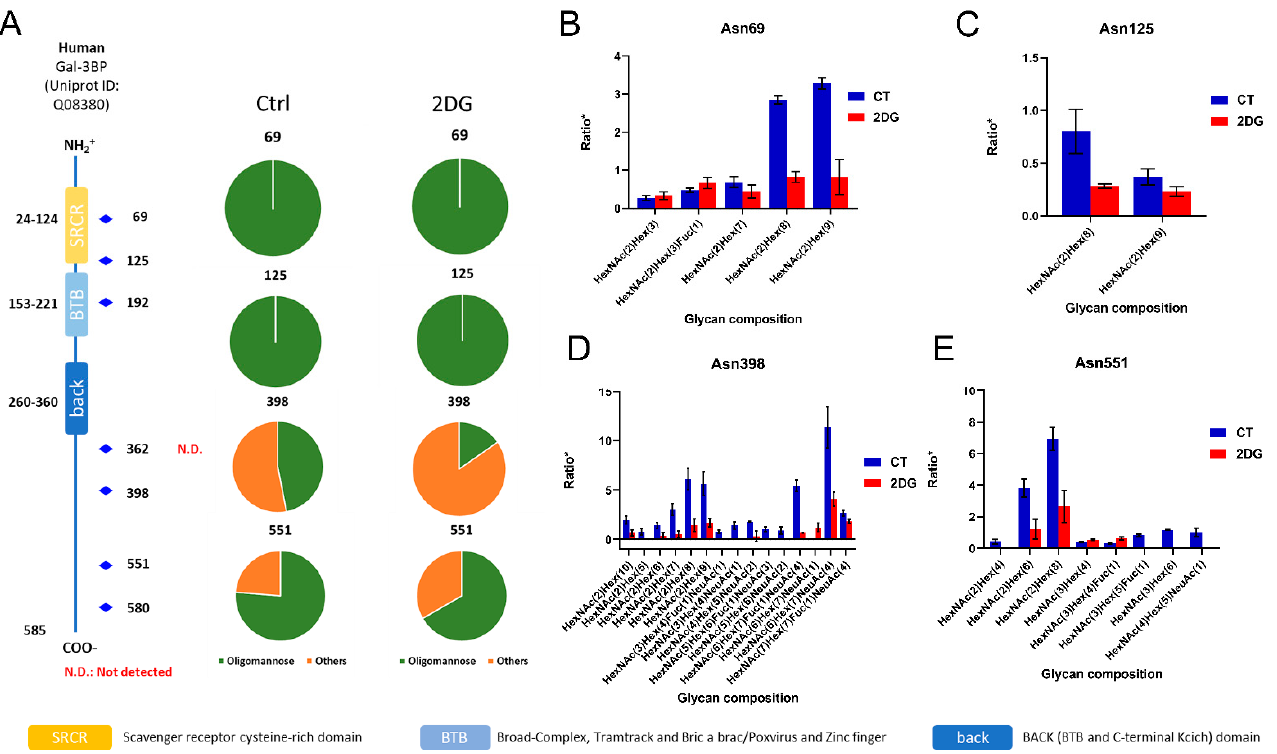
Figure 4. Alterations in the N -glycoforms of galectin 3-binding protein in HT29 cells induced by 2DG. ( A ) Site-specific N -glycosylation changes in galectin 3-binding protein at N -glycosites of Asn69, Asn125, Asn398, and Asn551. ( B , C ) Glycoforms with high-mannose identified at Asn69 and Asn125 sites showing a significant decrease or even completely inhibition in glycosylation due to 2DG treatment. ( D , E ) Glycoforms at Asn398 and Asn551 with not only high-mannose, but also complex and hybrid N -glycans, showing a similar influence from 2DG treatment, in particular mannosylation. Ratio* represents the XIC of the target peptide/internal standard